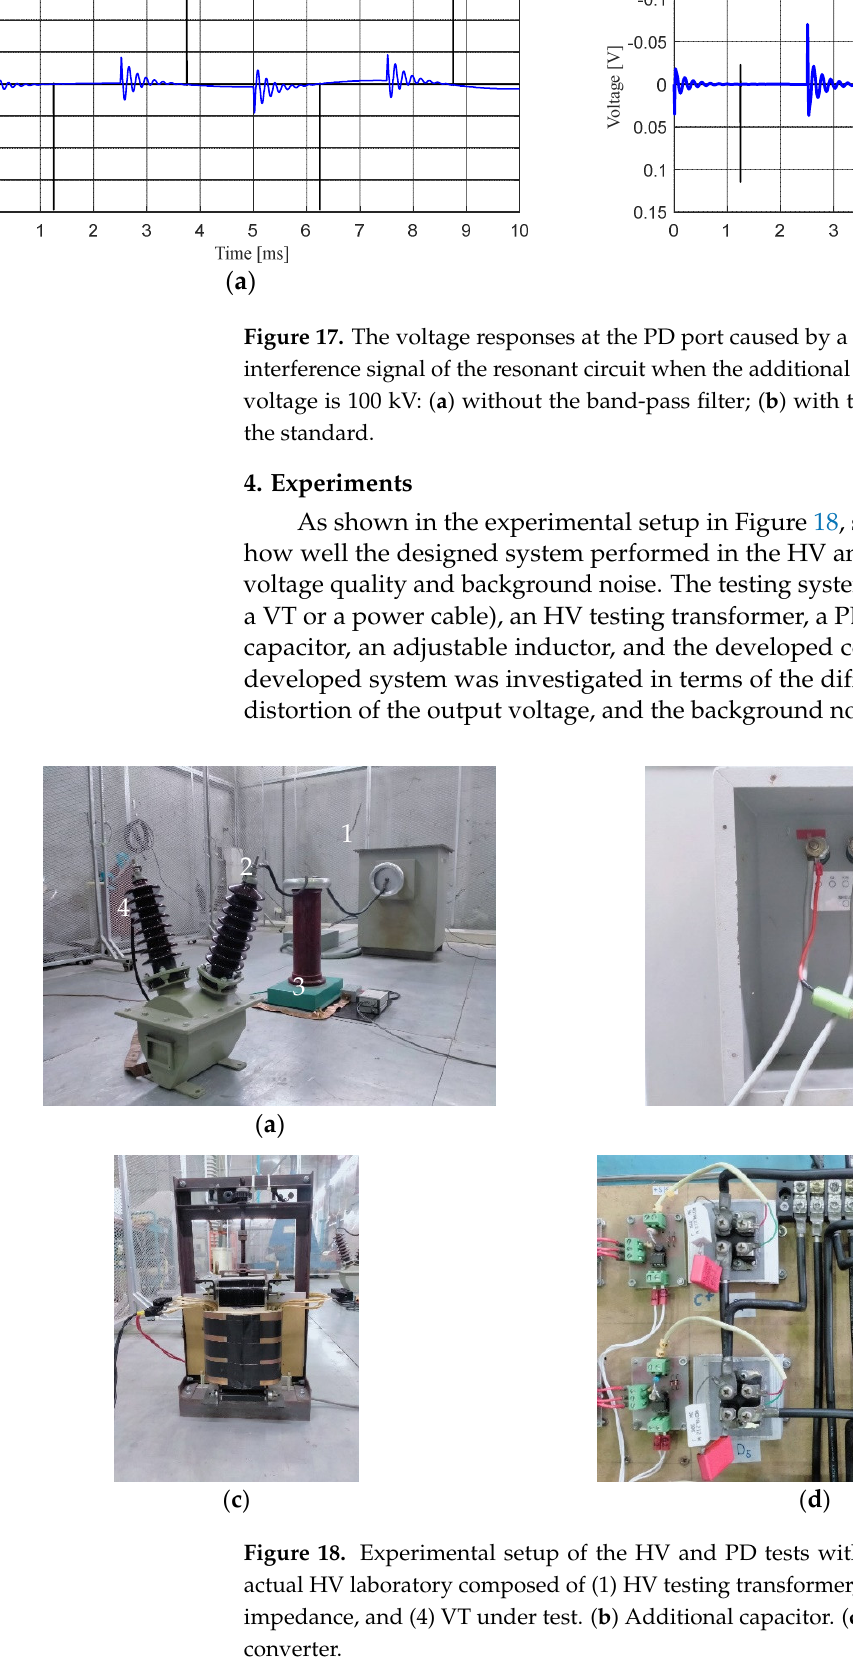
Figure 16. The input and output voltages of the testing transformer (all transferred to the HV side).